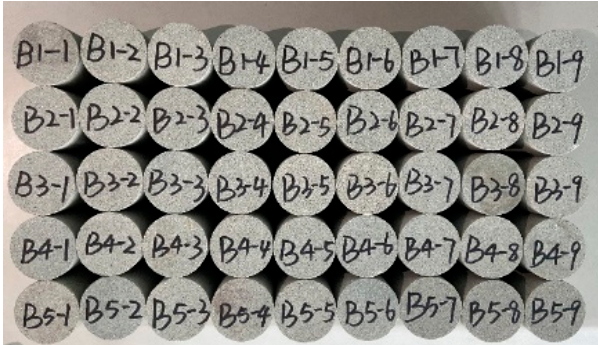
Figure 1. Standard specimen of cementitious sandstone.